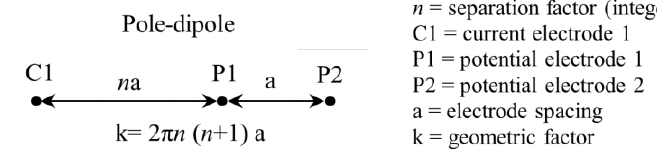
Figure 2. Electrode arrangement for resistivity array of pole-dipole [59].